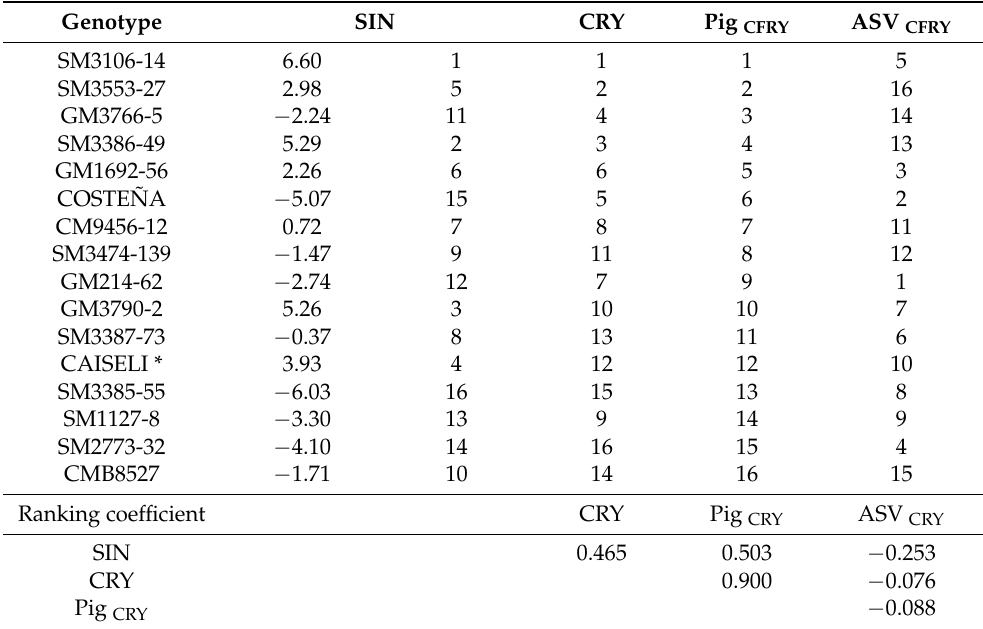
Table 7. Ranking and correlation for the commercial fresh root yield (CFRY), the selection index (SIN), and the phenotypic stability (Pig and ASV) of 16 cassava genotypes. Genotype SIN CRY Pig CFRY ASV CFRY